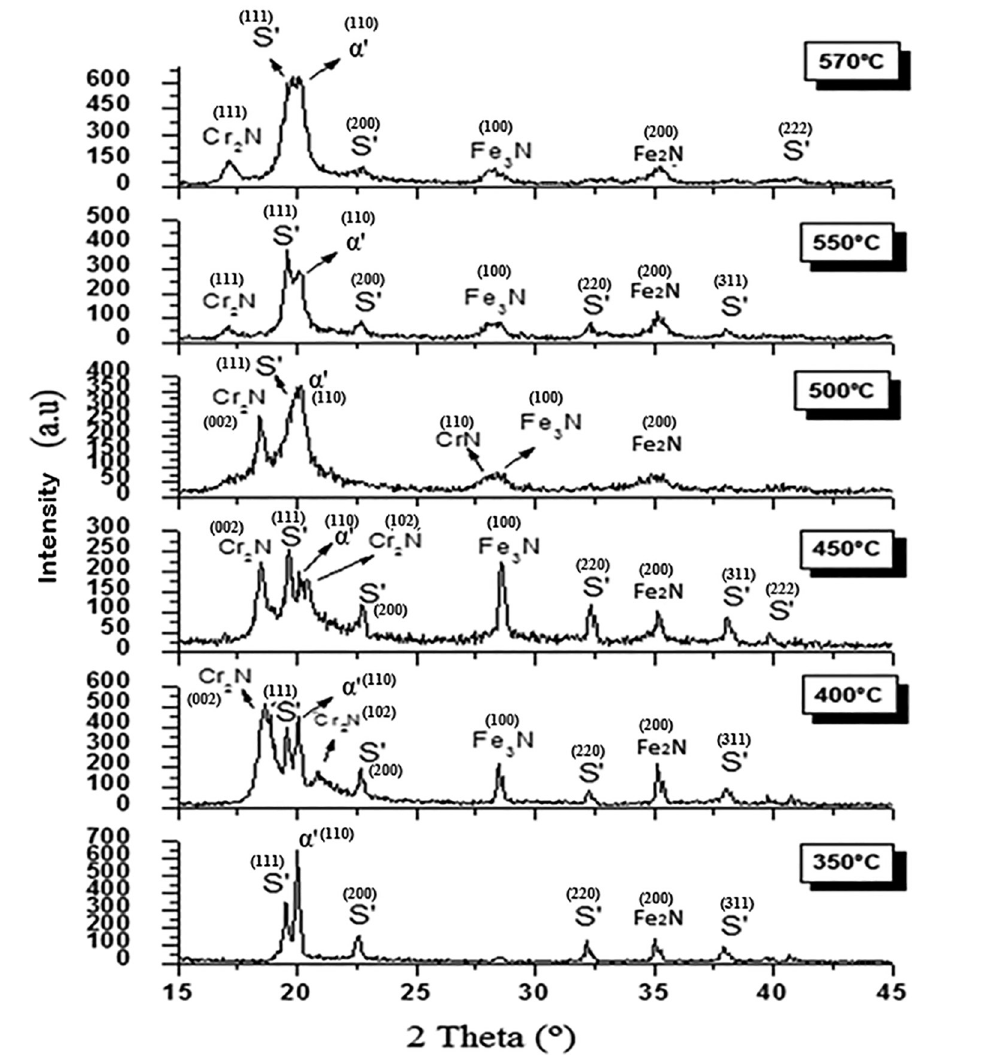
Figure 12: X-ray diffractograms for various nitriding